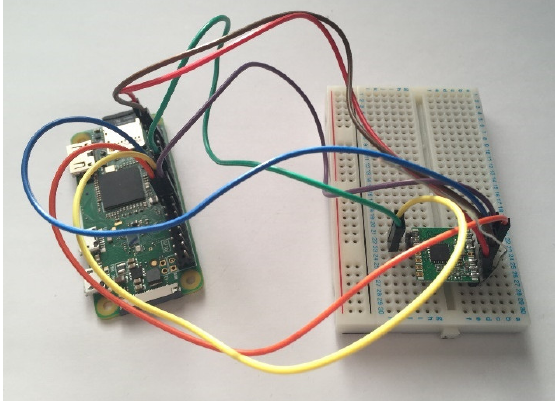
Figure 17. Photo showing the final base station.